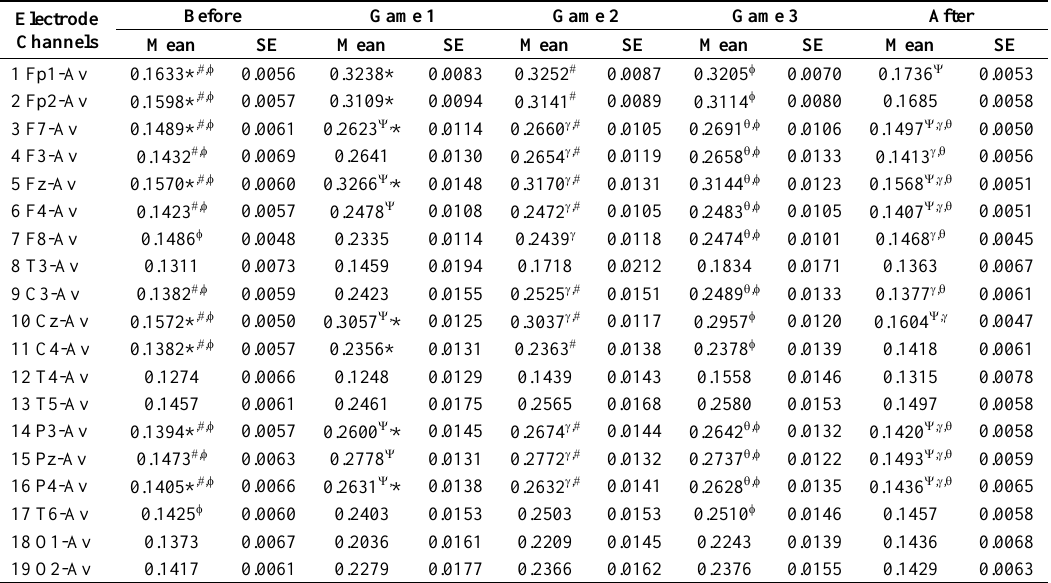
Table 4 Theta relative band powers between non-gameplays and during gameplays (*: before-game1,  : before-game2,  : before-game3,  : after-game1, 